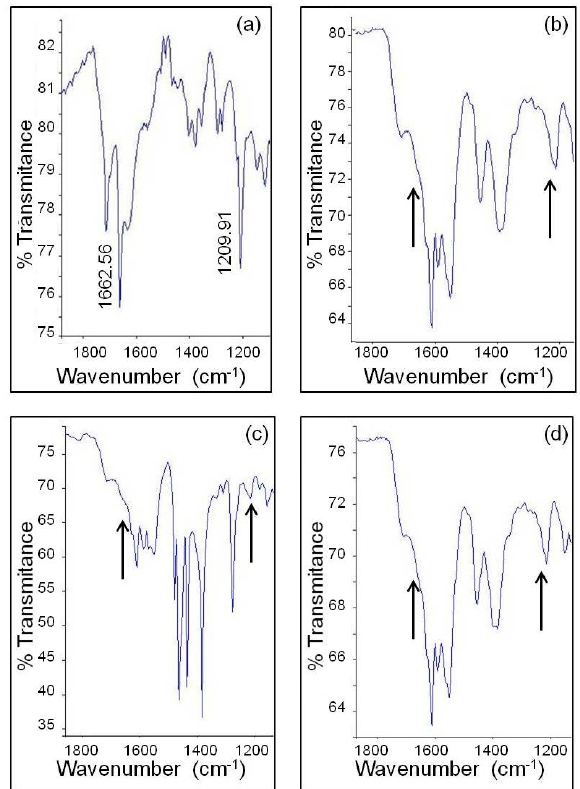
Figure 8. Infrared spectra of β -hematin obtained from hemin with characteristic β -hematin bands